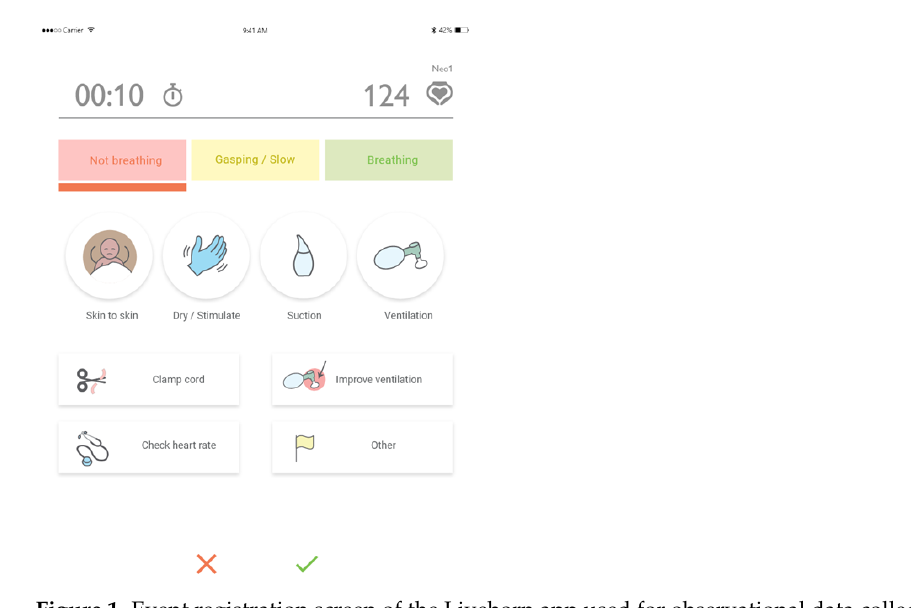
Figure 1. Event registration screen of the Liveborn app used for observational data collection.